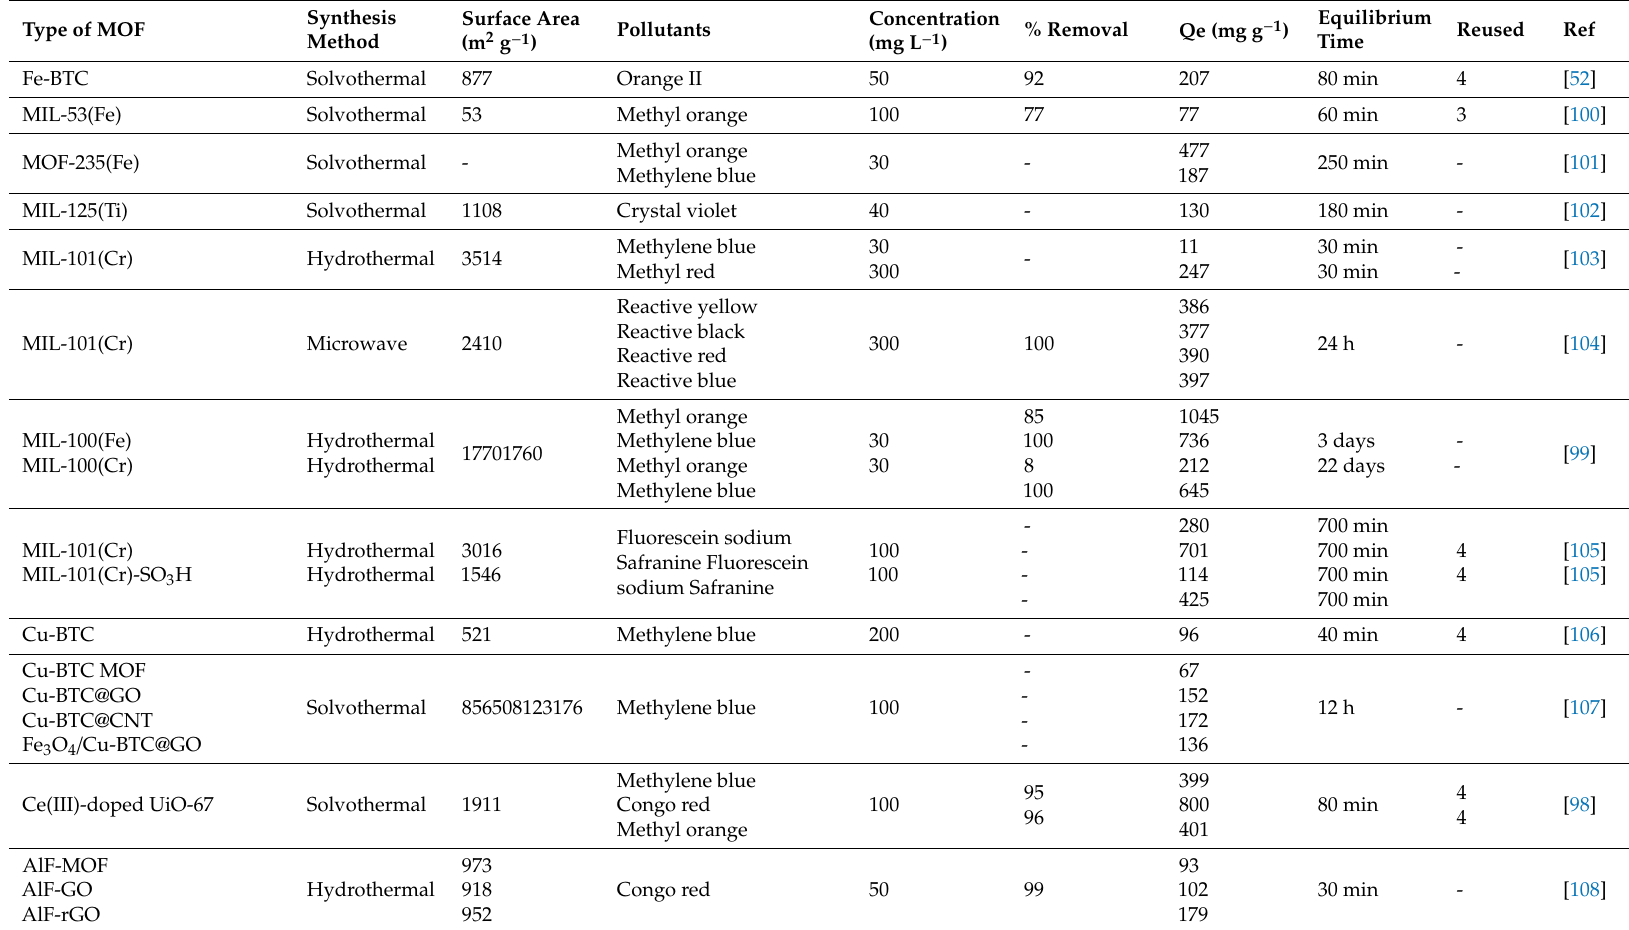
Table 1. MOFs reported for the adsorption of